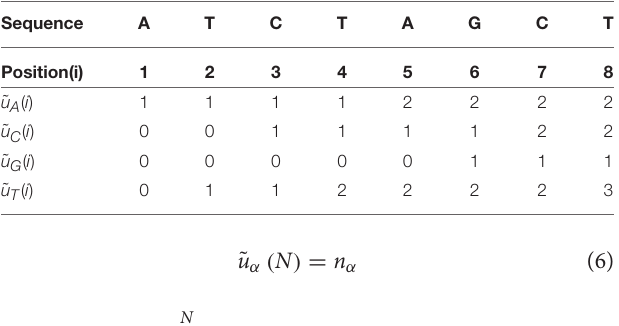
TABLE 2 | The Accumulated Indicator Functions of the sequence “ATCTAGCT.” Sequence A T C T